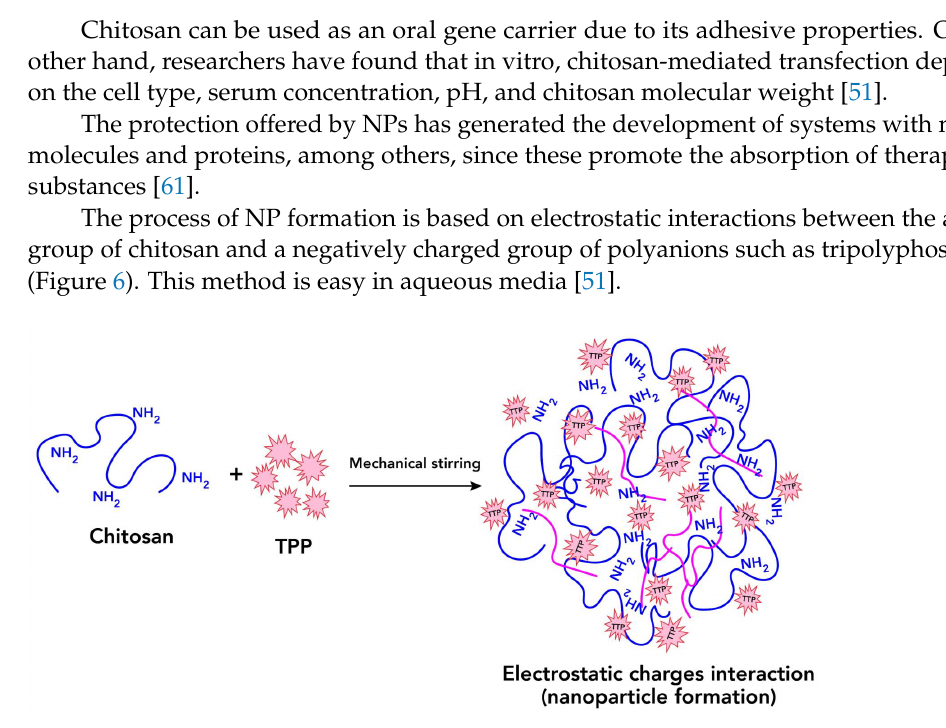
Figure 6. Electrostatic interaction between NH2 group of chitosan and negative charge of